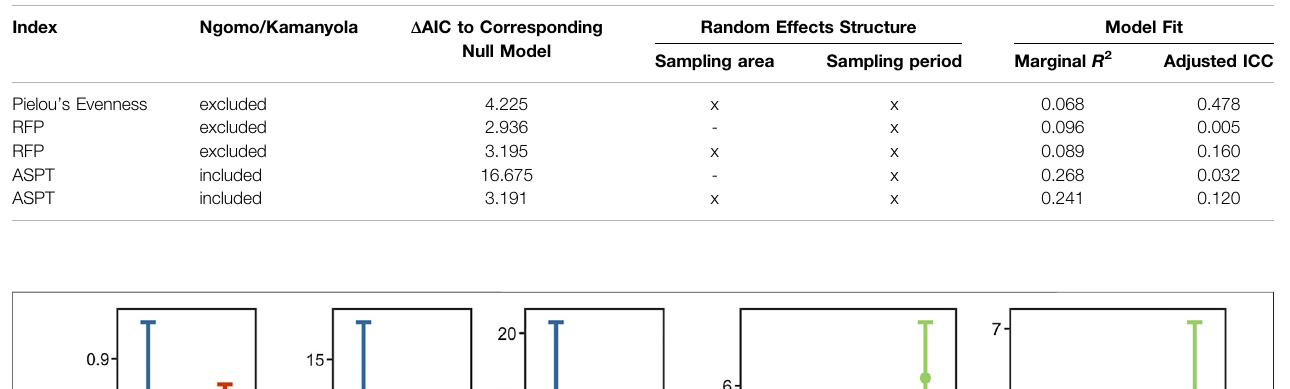
TABLE 2| Linear mixedeffects modelsthatarebetterthantheircorrespondingnullmodels, withindication ofrandomeffects structure (random intercept) and model fi t.See Supplementary Table S2 for the complete list and Supplementary Results S1 for model diagnostics. AIC, Akaike Information Criterion; ASPT, average score per taxon; ICC, intraclass correlation coef fi cient; RFP, rare family prevalence.